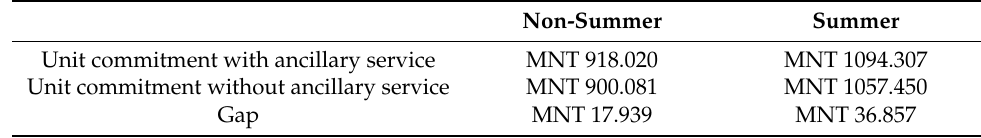
Table 5. Electric energy and ancillary service cost